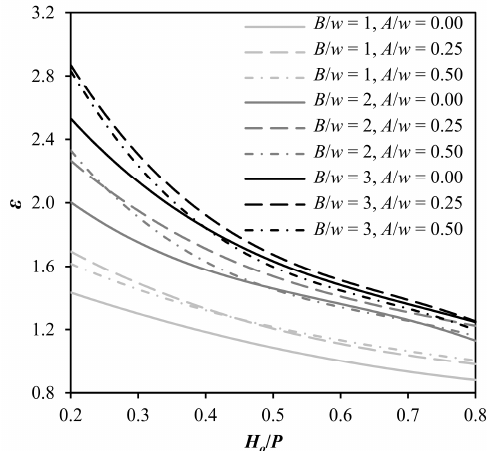
Figure 20. Efficiency curves.